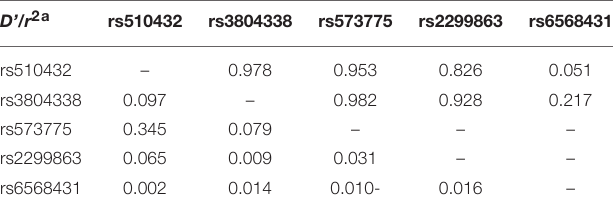
TABLE 3 | The linkage disequilibrium among ATG5